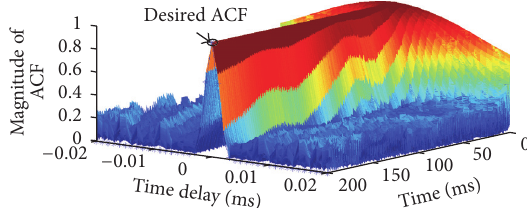
Figure 7: Magnitude of time-variant ACF of generated fading channel. The dotted line denotes the theoretical ACF corresponding to the Gaussian-shaped DPSD in Figure 3.